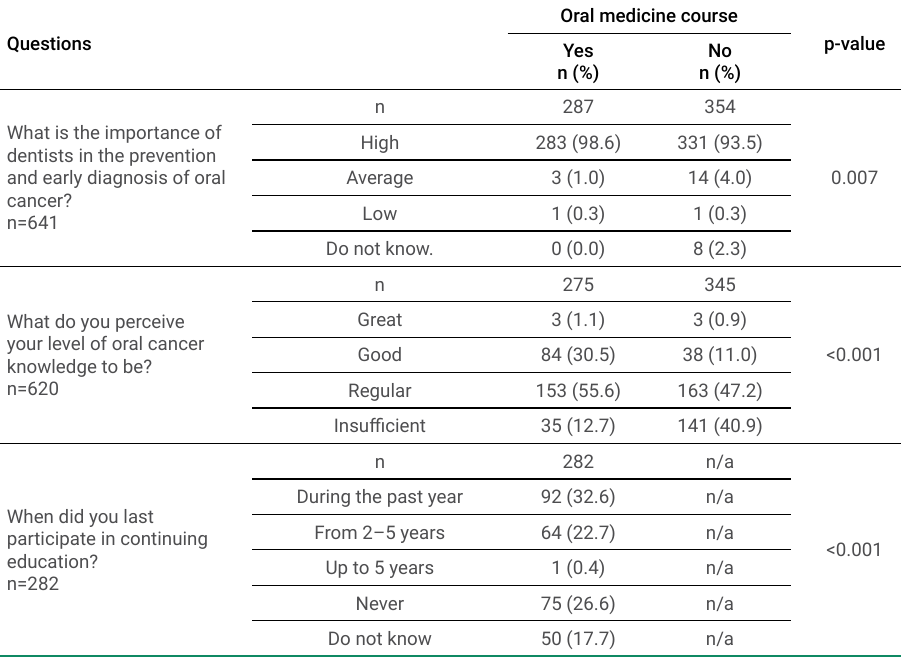
Table 4. Perception of knowledge, dentists’ importance, and continuing education (N= 646; Paraná, Brazil).